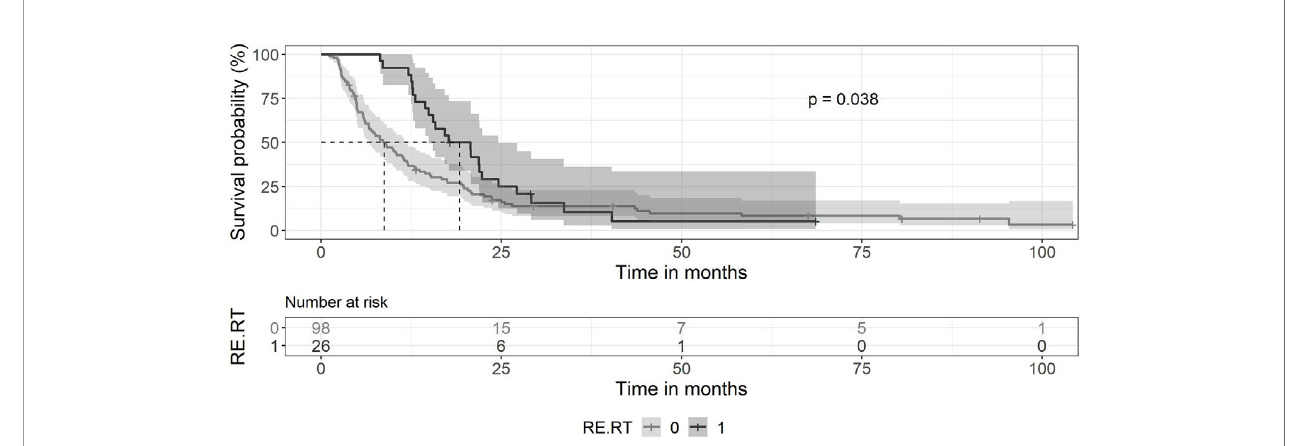
FIGURE 2 | Kaplan-Meier curves for survival between patients treated with primary chemoradiation without SRT and patients retreated with SRT. Ninety-eight patients without SRT (gray line) showed a median survival of 8.8 months (0.95 LCL – 0.95 UCL: 6.7 – 11.9 months). The median survival of patients with SRT (black line) was 19.2 months (0.95 LCL – 0.95 UCL: 14.9 – 24.6 months).